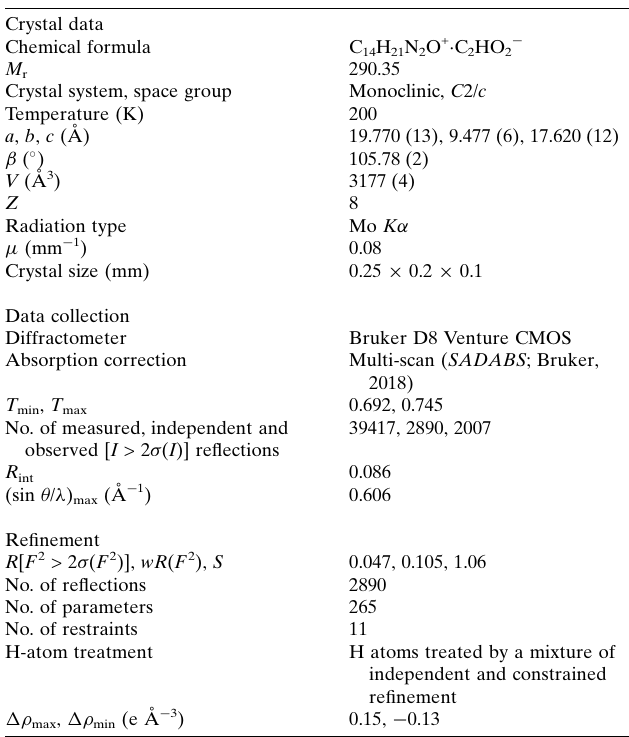
Table 2 Experimental details. Crystal data Chemical